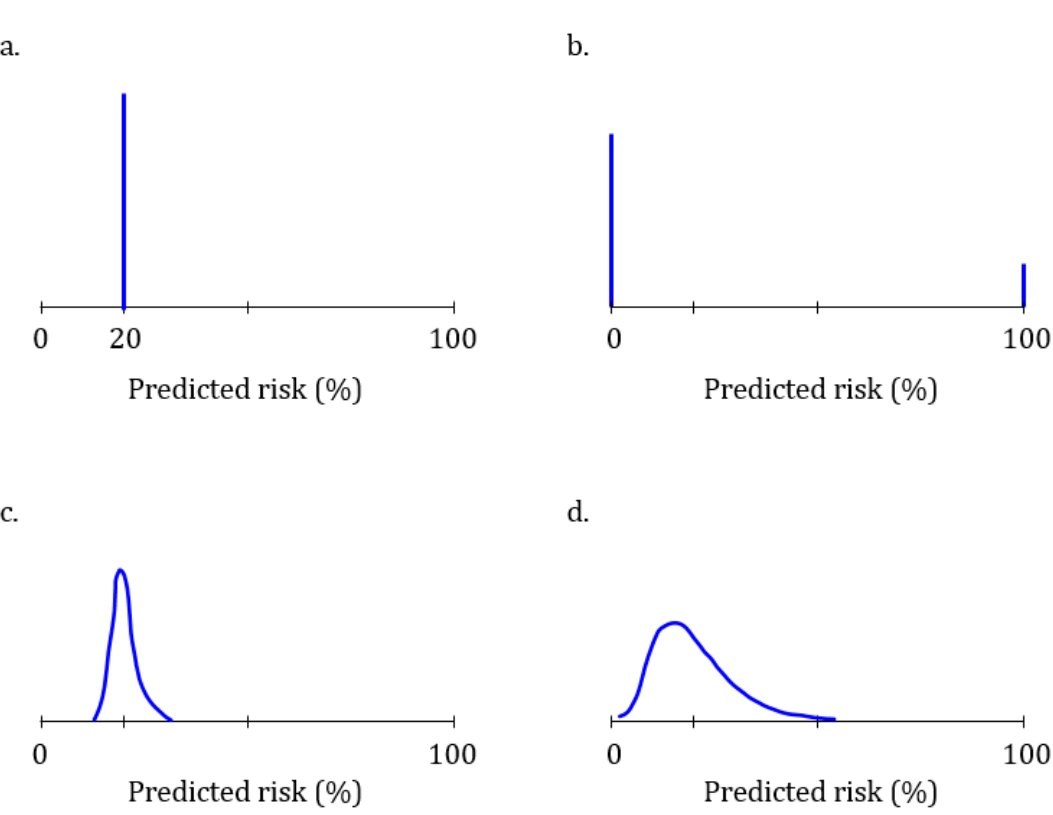
Figure 1. Risk distributions of four di ff erent polygenic algorithms for a hypothetical disease that a ff ects 20% of the population. ( a ) Uninformative polygenic algorithm that predicts a 20% risk of disease for everyone; ( b ) Perfect polygenic algorithm that predicts a 100% risk for the 20% of the people who will develop the disease and 0% risk for the other 80%; ( c , d ) Polygenic algorithms with lower ( c ) and higher ( d ) predictive ability.